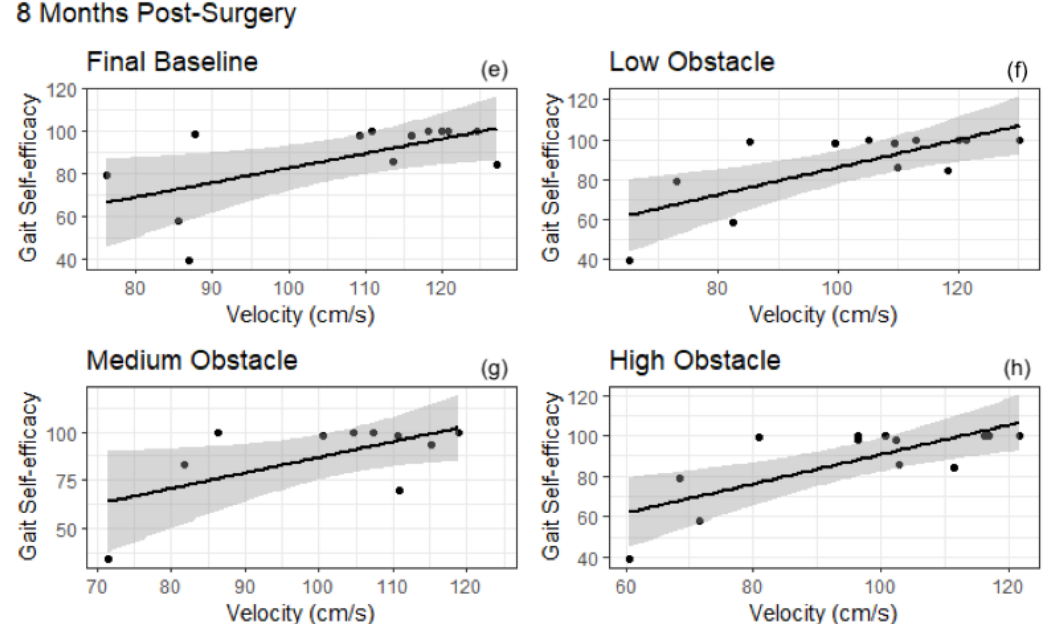
Figure 2. Correlations between gait self-efficacy and velocity for final baseline ( a , e ), low obstacle ( b , f ), medium obstacle ( c , g ) and high obstacle conditions ( d , h ) after bariatric surgery. Gait self-efficacy were significantly associated with velocity in all conditions. A general linear model was used to fit the trend lines. Clouds represent 95% CI.